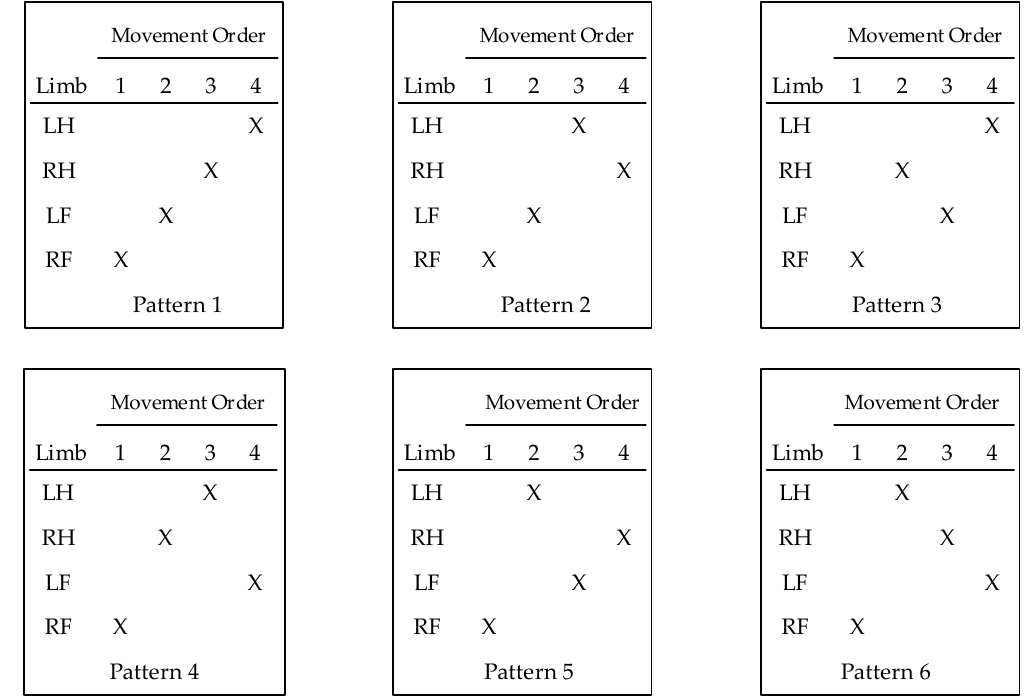
Figure 1. Hypothesized taxonomy of four-beat ladder climbing patterns with ordered limb movements. Limb notation: left hand (LH), right hand (RH), left foot (LF), right foot (RF).